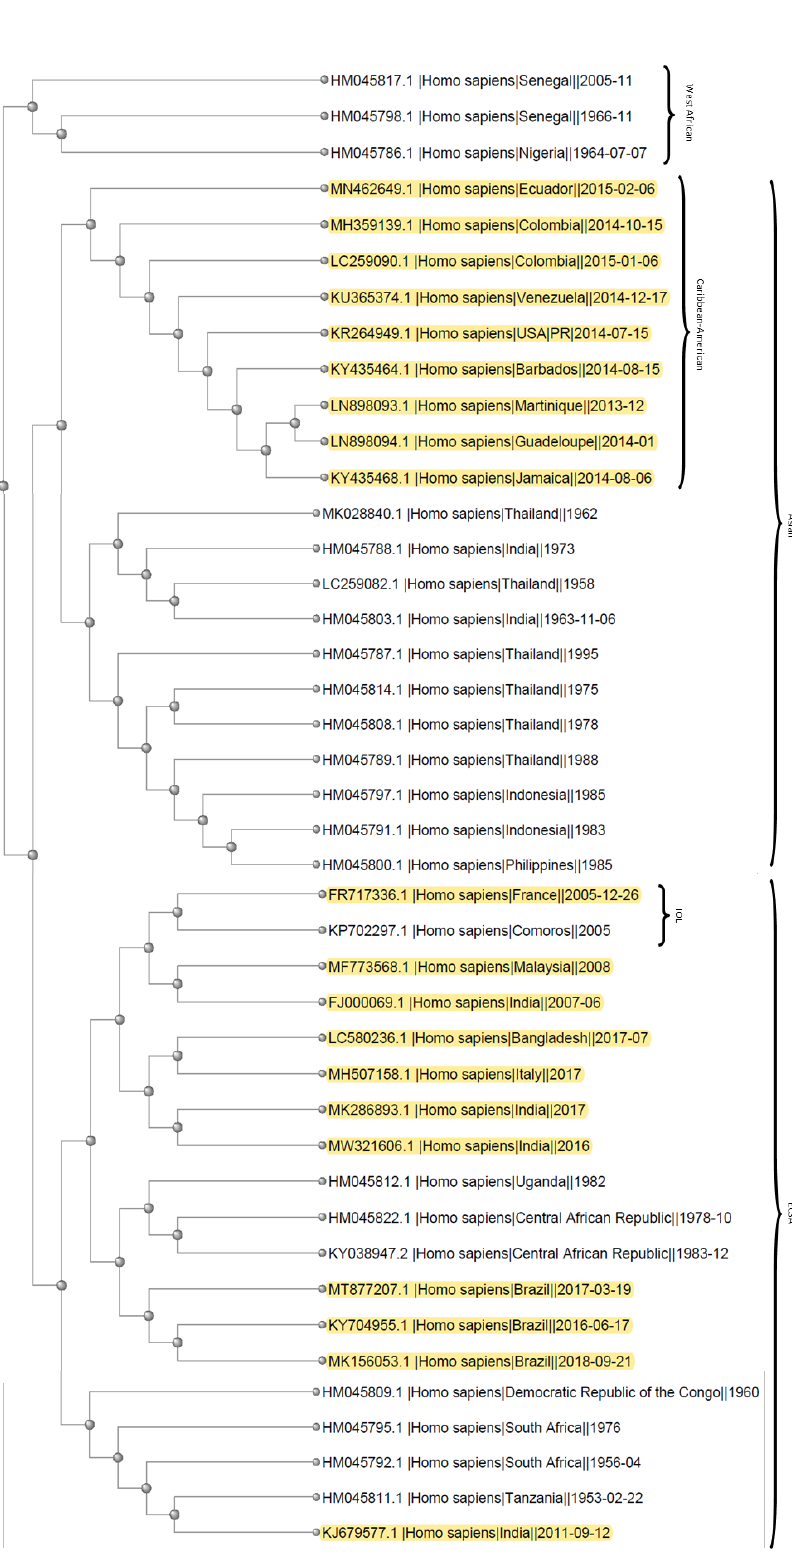
Figure 3. Phylogenetic tree listing several outbreaks from 1953 through 2005, with the addition of the strains in Figure 2. These strains and the tree were developed using the NCBI Viruses database [23]. Based on the strain data from NCBI, the three main branches are labeled to indicate West Af- rican, ECSA, or Asian lineages. Additionally, the sub-lineages for IOL and Caribbean-American are labeled. The strains from Figure 2 are highlighted.